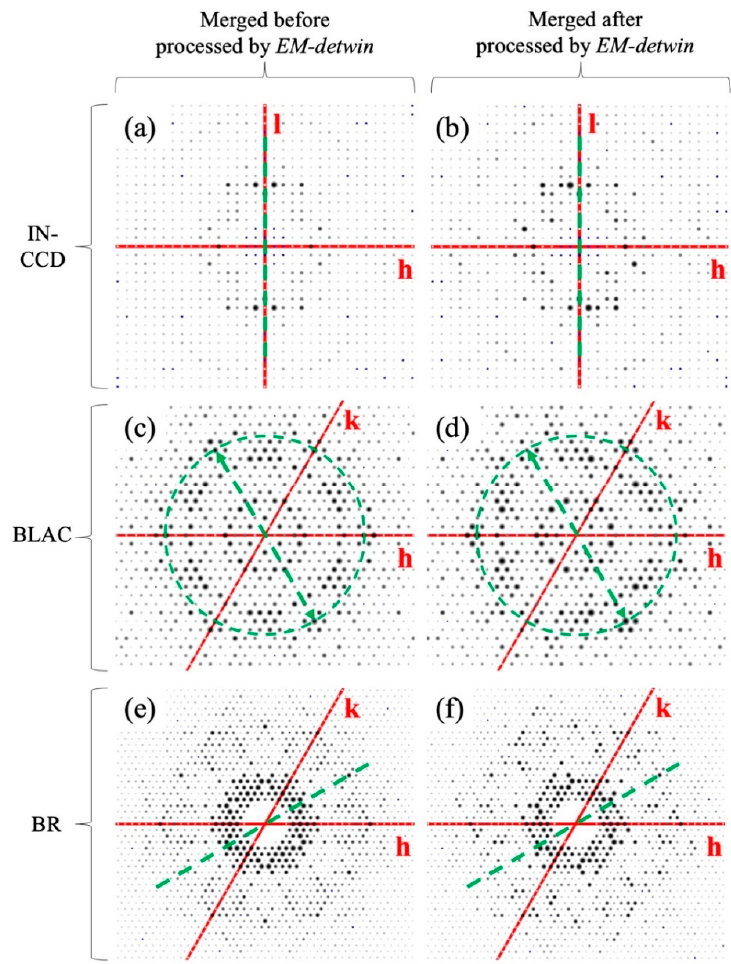
Figure 2. Di ff erences between merged di ff raction intensities before and after being processed by EM-detwin . ( a , b ) Di ff raction intensities on the (h,0,l) plane of the Integrase Catalytic Core Domain (IN-CCD), where the green dashed line represents the twinning symmetry “(h,0,l) = ( − h,0,l)”; ( c , d ) (h,k,5) plane of Beta-lactamase (BLAC) reflections, where the green arrows indicate the twinning symmetry “(h,k,5) = ( − h, − k,5)” (central symmetry in planes for fixed l ); ( e , f ) (h,k,0) plane of BR reflections, where green dashed line represents the twinning symmetry “(h,k,0) = (k,h,0)” (rotational symmetry).